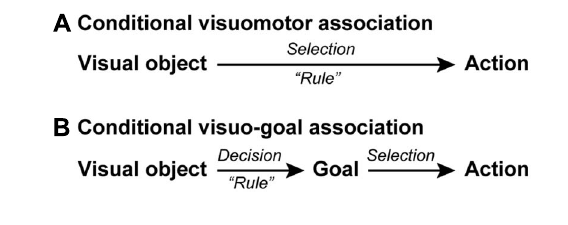
FIGURE 1 | Schematic representations of conditional visuomotor association and conditional visuo-goal association. (A) In conditional visuomotor association, perceptual signals representing visual objects are directly mapped onto the motor signals (actions) in a rule -dependent manner to achieve an action selection. (B) In conditional visuo-goal association, perceptual signals are first mapped in a rule -dependent manner onto signals representing behavioral goals for making a goal decision.The goal-related signals are subsequently transformed into signals representing actions, corresponding to an action